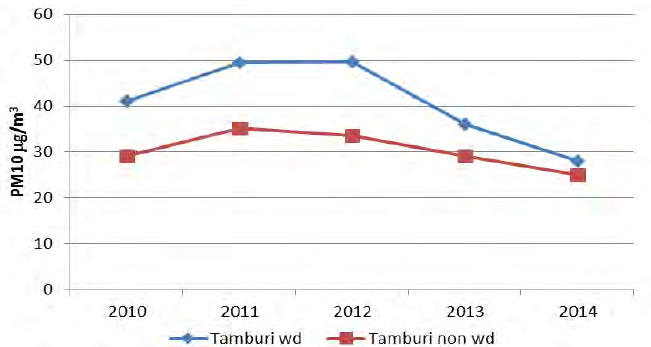
Fig. 7a: WD and nWD PM10 concentrations in Tamburi site